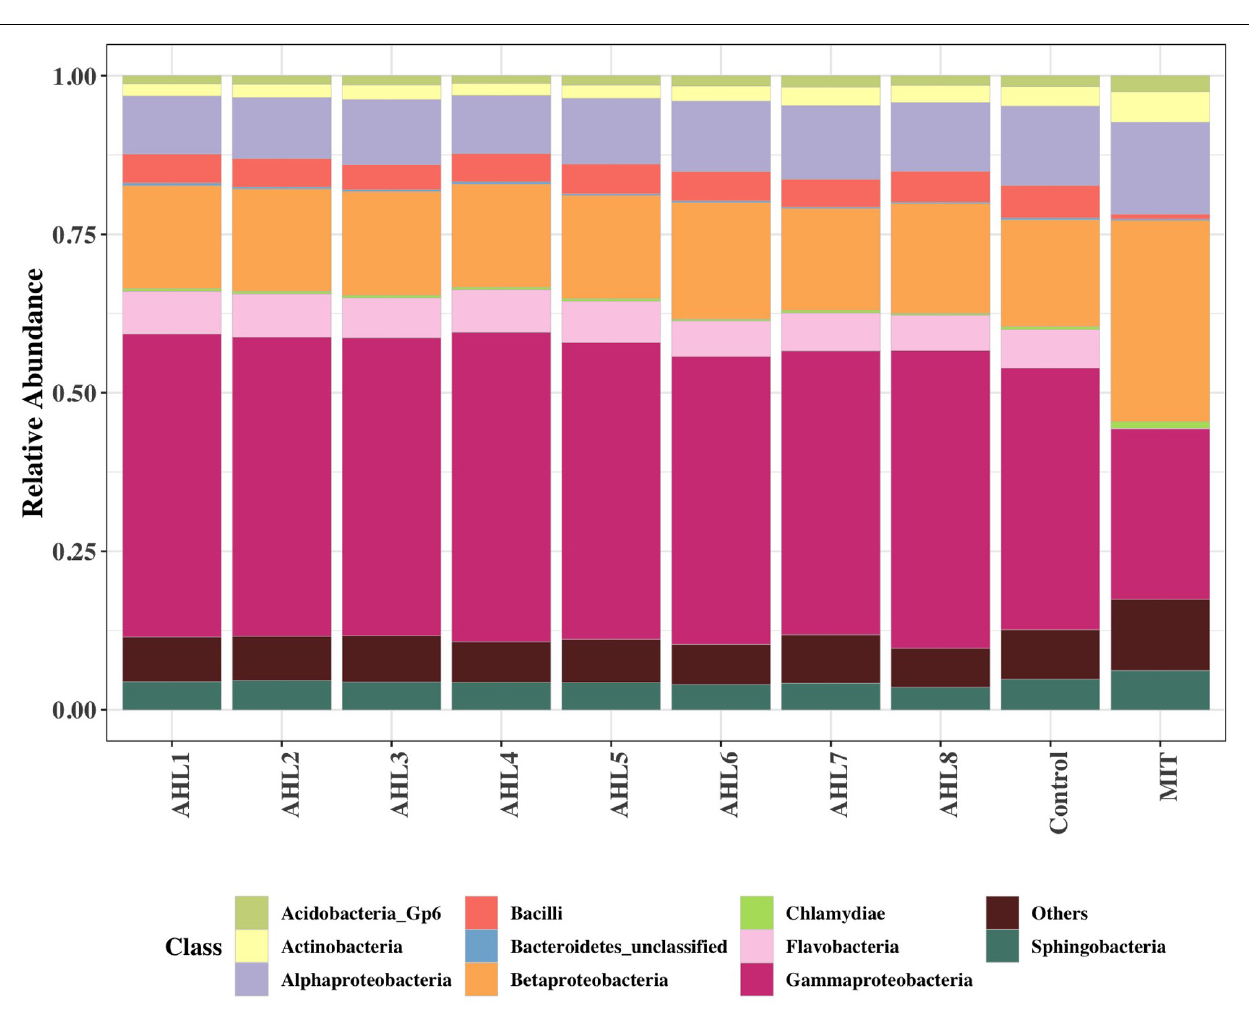
FIGURE 3 | Class-level community composition showing the relative abundances of dominant bacterial classes across all treated samples and the control group. Treatments include induction assays with either N-(Butyryl, Hexanoyl, β -Ketocaproyl, Heptanoyl, Octanoyl, 3-Oxododecanoyl, Tetradecanoyl, and 3-Oxotetradecanoyl) homoserine lactones (represented with AHL1–8, respectively) or mitomycin C